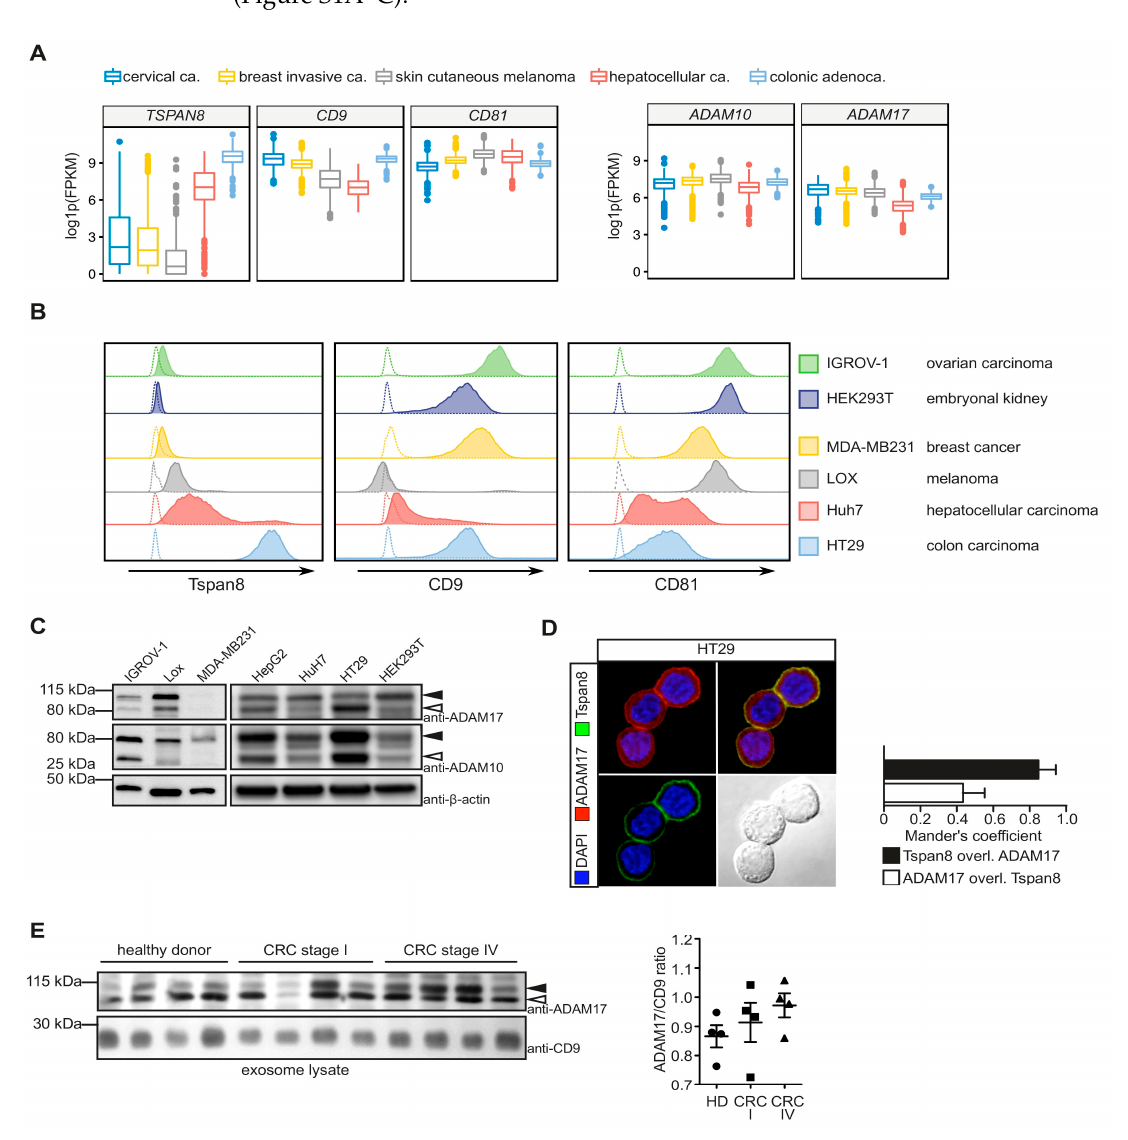
Figure 1. Expression of Tspan8 subfamily members and ADAMs in tumor cells. ( A ) mRNA expression of Tspan8, CD9 and CD81 is enhanced particularly in colonic adenocarcinoma, while expression of ADAM10 and ADAM17 can be detected in all tumor tissues analyzed. Expression data were retrieved from The Cancer Genome Atlas (TCGA). ( B ) Expression of Tspan8, CD9 and CD81 in the indicated tumor cell lines as assessed by flow cytometry. Dotted lines indicate unstained control. ( C ) Analysis of the indicated tumor cell lines for expression of ADAM10 and ADAM17 using SDS-PAGE and immunoblotting. ( D ) ADAM17 and Tspan8 co-localize at the cell surface of HT29 colon carcinoma cell line as assessed by immunofluorescence. ( E ) ADAM17 is enhanced in CD9+ exosomes isolated from the serum of patients suffering from colorectal cancer (CRC). Shown is the immunoblot of exosome lysates (left panel) and the densitometric quantification (right panel). HD: healthy donor, black filled arrow heads: ADAM10/ADAM17, pro-form, black open arrow heads: ADAM10/ADAM17 mature form. Data are represented as mean ± s.e.m., n = 3 independent experiments ( C ), One-way ANOVA on ranks with Dunn’s post-hoc test (E).